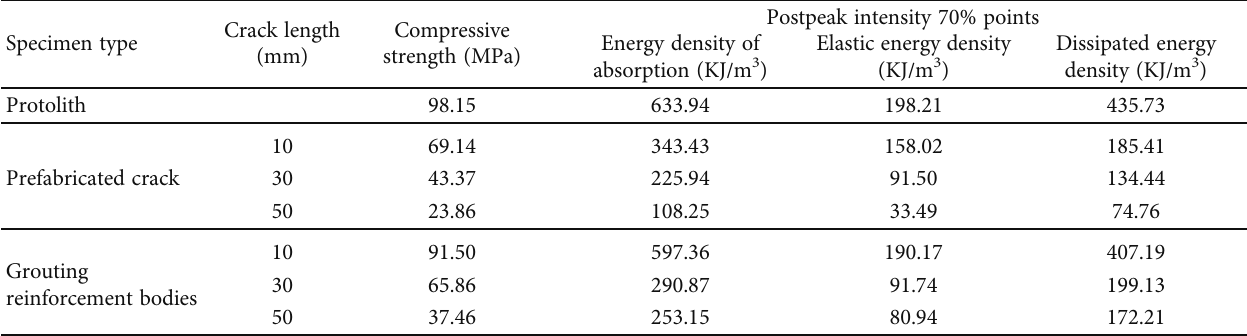
Table 3: Energy index value of each specimen in simulation tests.